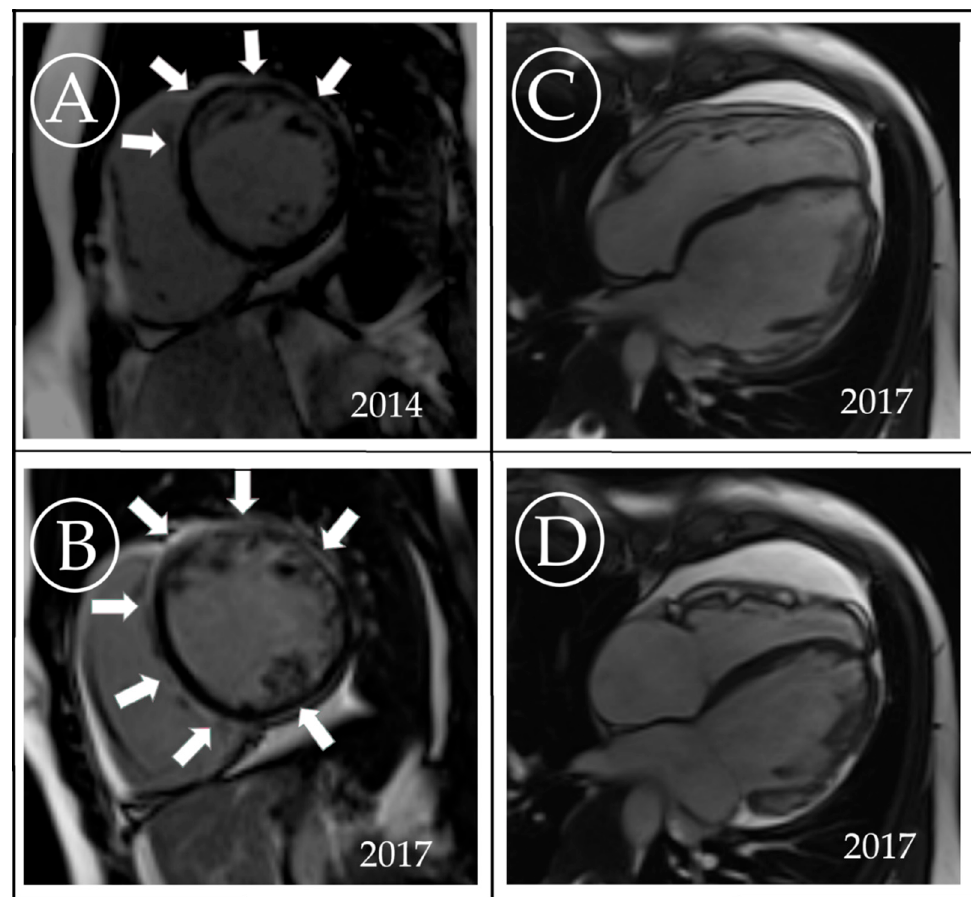
Figure 3. Cardiac magnetic resonance images consistent with the diagnosis of arrhythmogenic cardiomyopathy. ( A ) Short-axis slice demonstrating moderate sub-epicardial and mid-wall areas of late gadolinium enhancement with a ring-like pattern (arrows); ( B ) the progression of ring-like pattern fibrosis (arrows) in comparison to the study performed 3 years earlier; ( C ) steady-state free precession 4-chamber view in the end-diastole; ( D ) steady-state free precession 4-chamber view in end-systole. Areas of bulging of right ventricular wall are seen.